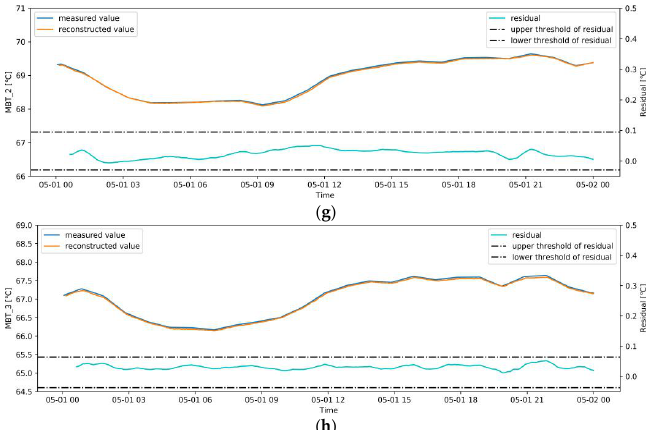
Figure 14. Real-time monitoring of variables in a normal case: ( a ) LOT; ( b ) POT_A1; ( c ) POT_A2; ( d ) MNDT; ( e ) MDT; ( f ) MBT_1; ( g ) MBT_2; ( h ) MBT_3.